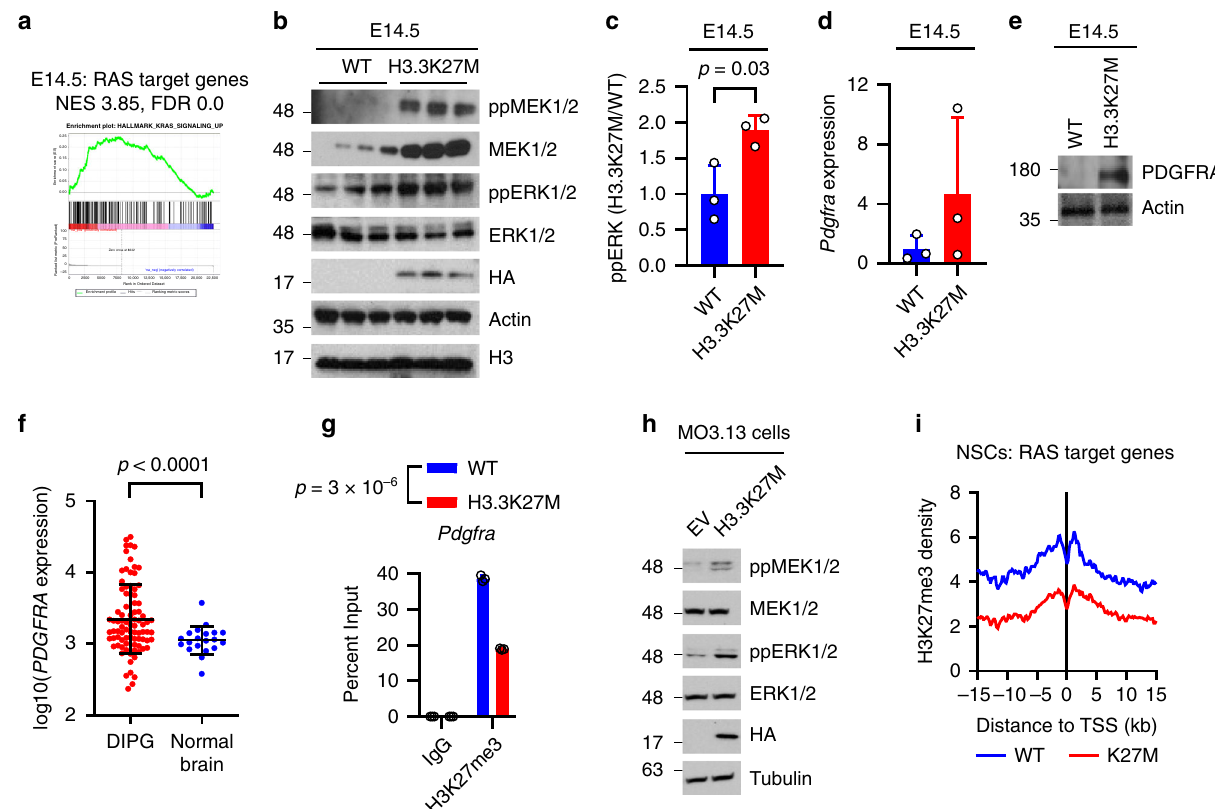
Fig. 5 Activation of RAS/MAPK is an early, epigenetically-driven effect of H3.3K27M. a Gene set enrichment analysis (GSEA) of RAS target genes in H3.3K27M E14.5 MB/HB. NES: Normalised Enrichment Score. FDR: false discovery rate. b Western blot of WT/K27M E14.5 MB/HB (results are representative of 2 independent experiments from different litters). c Densitometry quantifying ppERK in B as H3.3K27M vs WT (normalised to actin) and is plotted as mean ± standard deviation ( n = 3). d Pdgfra expression was measured by qPCR in 3 independent H3.3K27M or WT embryos, normalised to Gapdh and WT, and plotted as mean ± standard deviation. e Western blot of H3.3K27M and WT MB/HB from littermates harvested at E14.5. Note that the actin loading control is shared with Fig. 3b (results are representative of at least 3 independent experiments). f PDGFRA expression in human H3.3K27M DIPG ( n = 28) and normal brain ( n = 20). g ChIP quantifying H3K27me3 at the Sox10 promoter in E14.5 WT or H3.3K27M MB/HB. h Western blot of empty vector (EV)/H3.3K27M-expressing MO3.13 cells (results are representative of 2 independent experiments). i H3K27me3 ChIP-Seq density was pro fi led ± 15 kb around the transcription start site (TSS) of SOX10 target genes in H3.3K27M or H3.3WT NSCs 46 . Source data are provided as a Source Data fi le. Statistical tests: t ( c , f , g